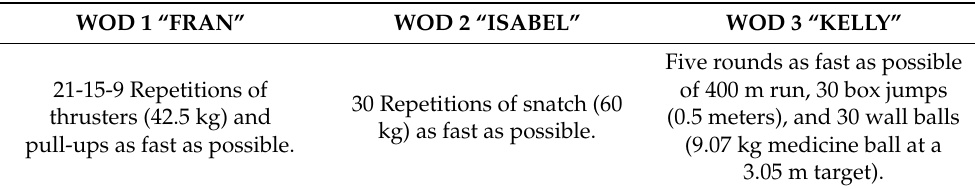
Table 1. Workouts performed in the simulated CrossFit ®